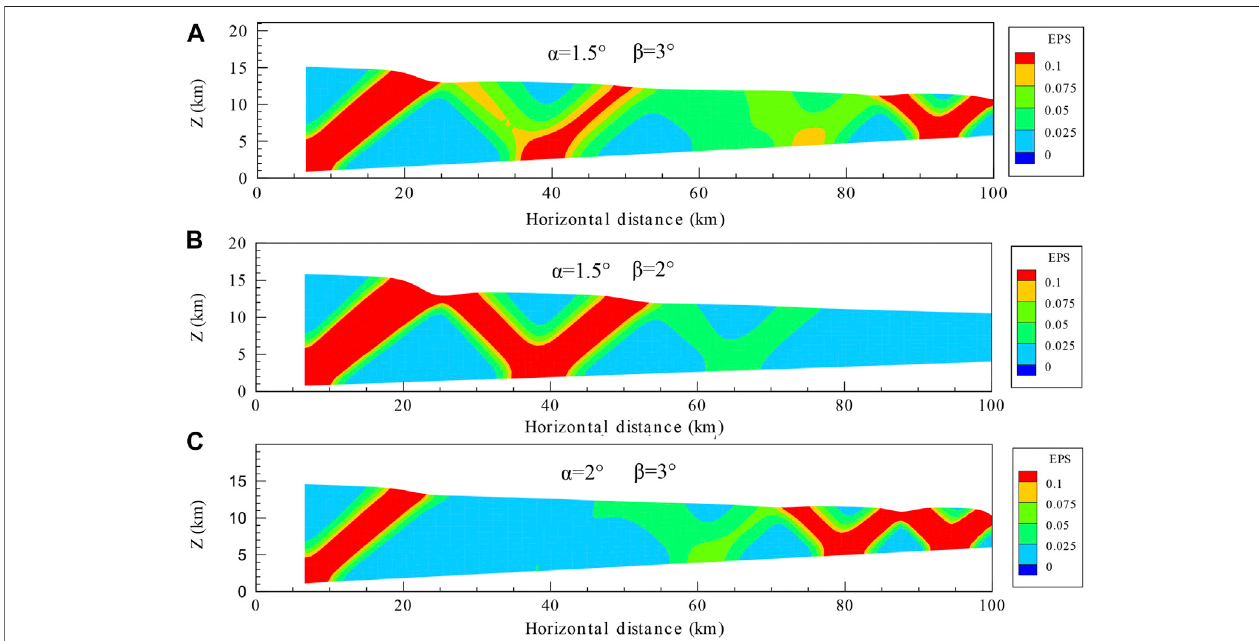
FIGURE 8 | Final state EPS for models with different boundary-surfaces ’ inclinations. After 6.6 km of shortening displacement, panels (A – C) show states of models1,2,and3,whichhaveinclinationangles( α , β )oftheirtopandbottomsurfacesof(1.5 ° ,3 ° ),(1.5 ° ,2 ° ),and(2 ° ,3 ° )respectively.Plasticityconcentrationpatternsare rather different among them. A slight trend being that higher surfaces ’ angles (on top or bottom) tend to favor plasticity in thinner region of wedge.